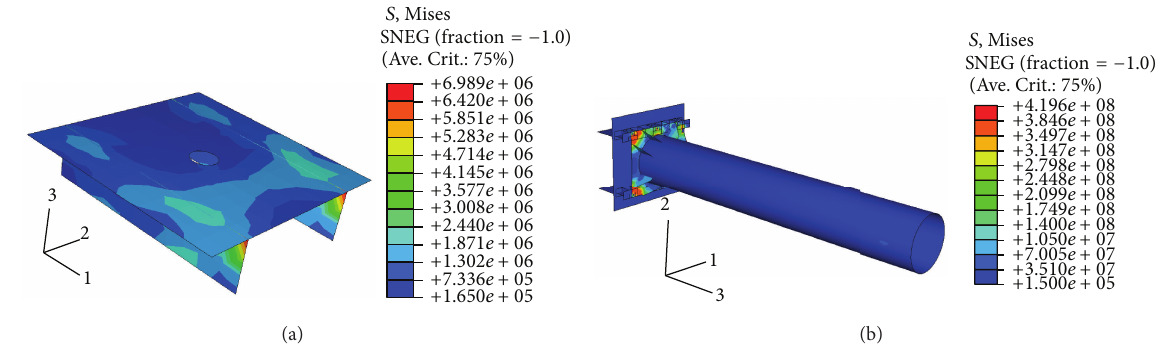
Figure 11: The von Mises stress (Pa) distribution in the model (vertical position in compartment).